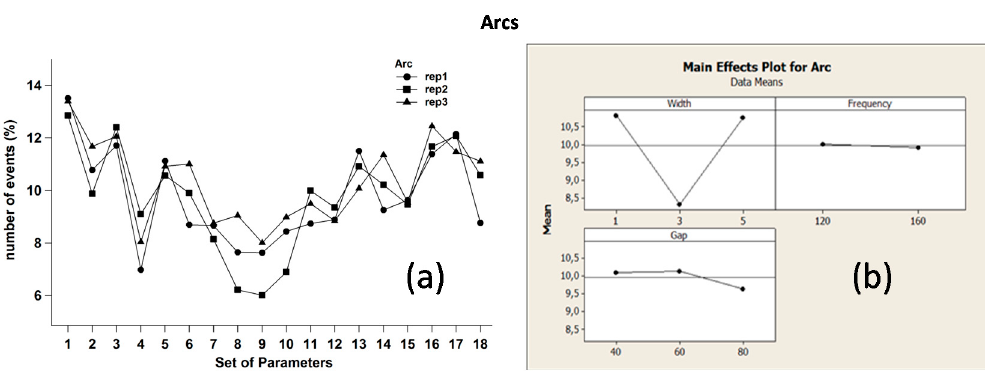
Figure 8. ( a ) Replica diagrams and ( b ) main effects plot related to arc pulses.